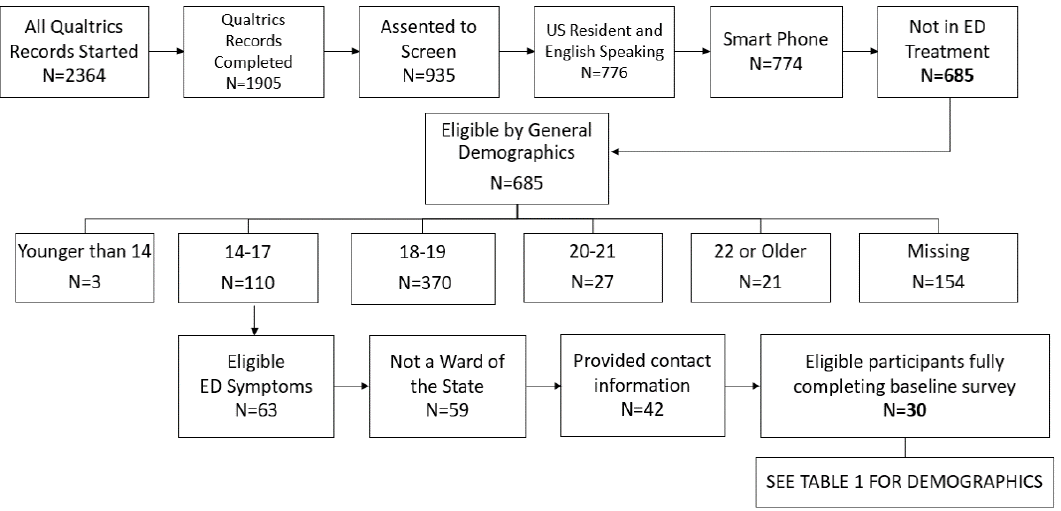
Figure 2. Participants eligible after each online screening step—Testing Phase. Bold numbers indicate those eligible after initial demographic screening questions (N = 685) and those enrolled into the study (N = 30).